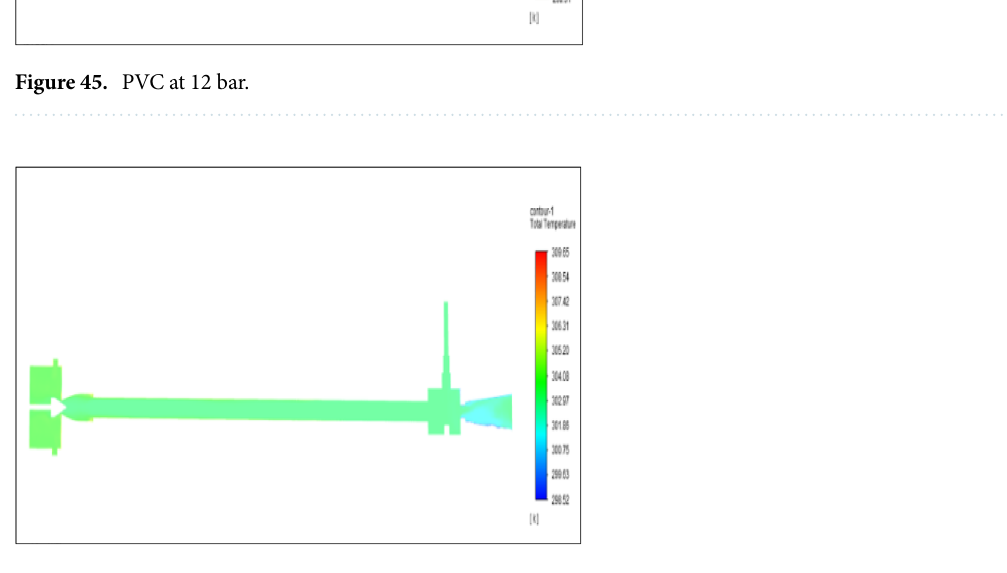
Figure 46. CPVC at 12